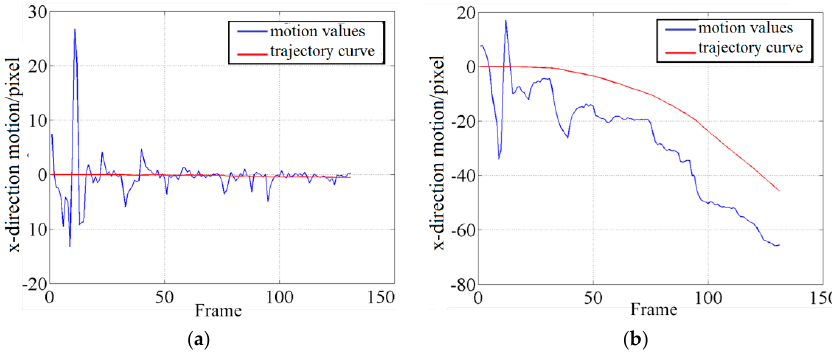
Figure 16. X-direction motion values between two frames in the same image sequence when ( a ) the adjacent frame and ( b ) the selected frame were used as the reference frame.